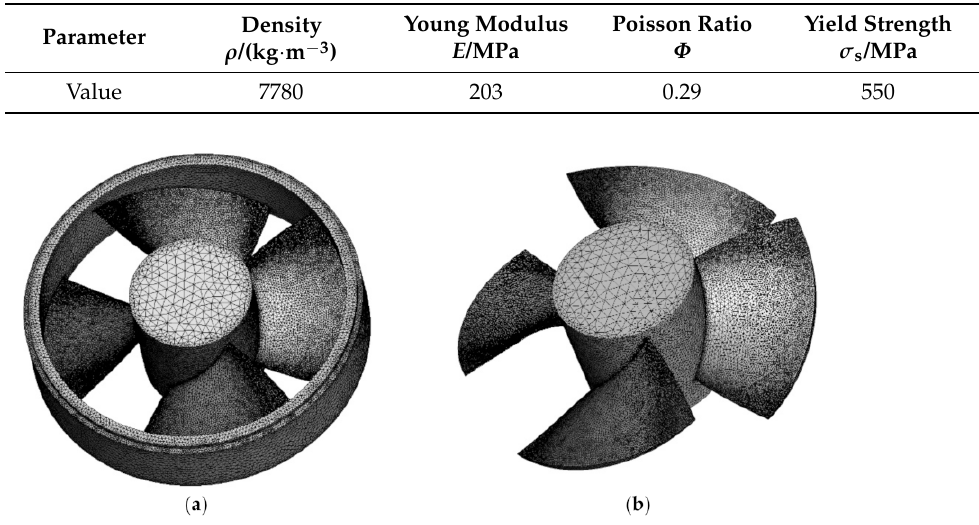
Figure 3. Impeller structure model: ( a ) the full tubular pump impeller, ( b ) the axial-flow pump impeller. Table 2. The material properties of the impeller.